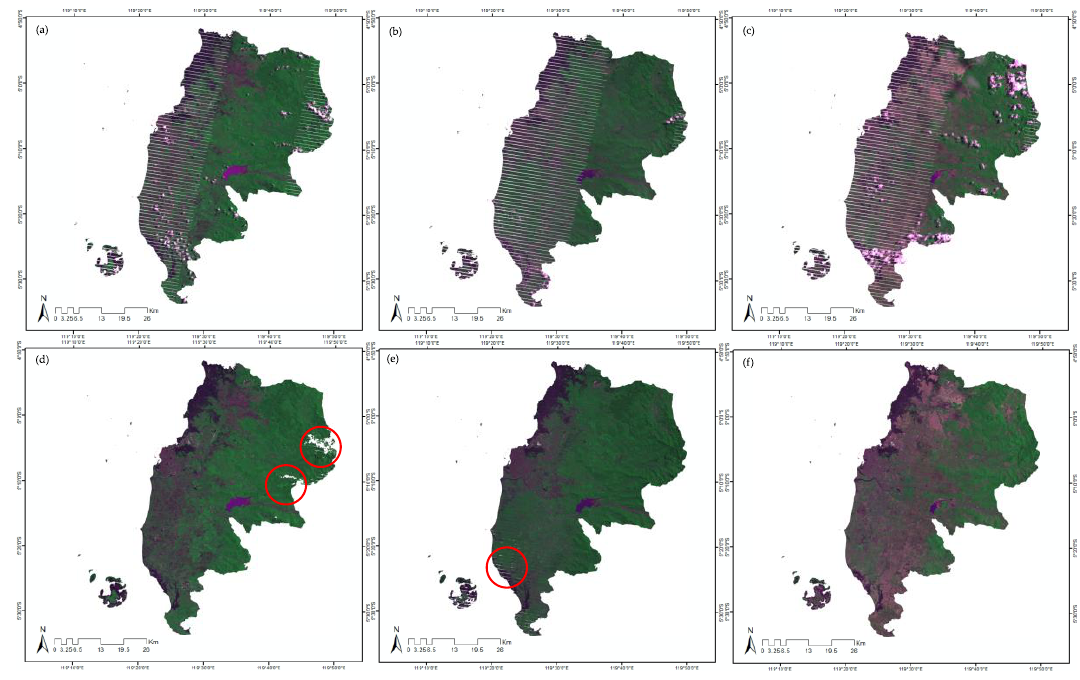
Figure 4. Landsat 7 ETM+ 2011: ( a ) scene 1 (11/04/2010), ( b ) scene 2 (03/07/2011), and ( c ) scene 3 (05/09/2011) before composite; ( d ) scene 1, ( e ) scene 2, and ( f ) scene 3 after composite. Note: red circles indicated no-data; bands 3, 4, and 2 were used for red, green, and blue, respectively.